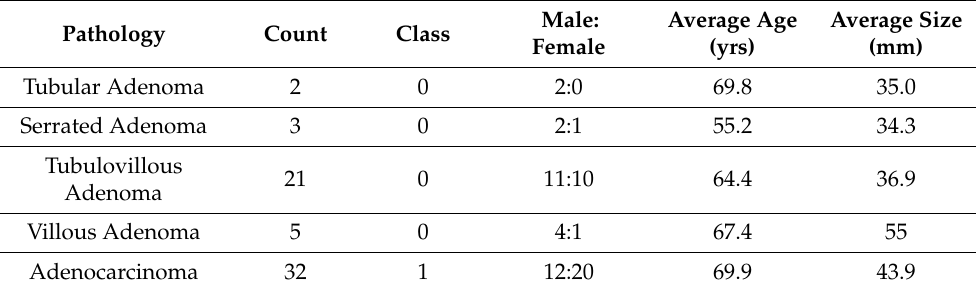
Figure 6. Flowchart of data acquisition and preparation for these experiments. Table 3. Patient demographics of polyp mass dataset.